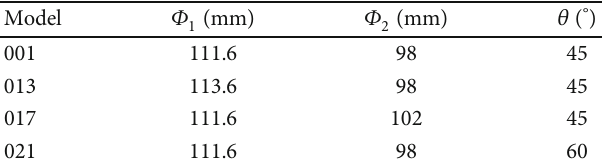
Table 2: Design parameters table for each fi nger lock. Model